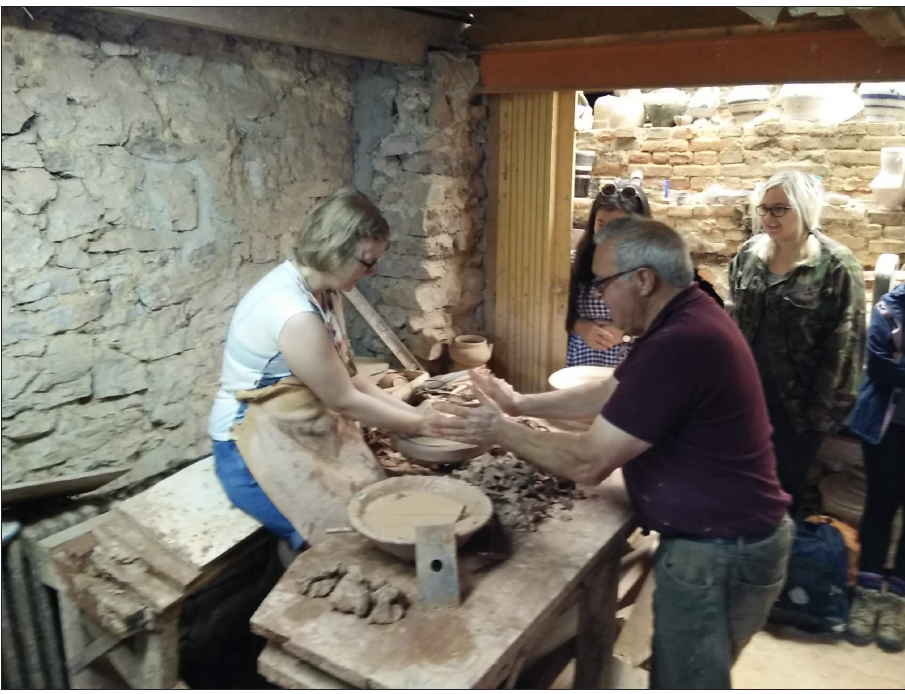
Figure 1: Selito demonstrating traditional ceramic techniques to students from